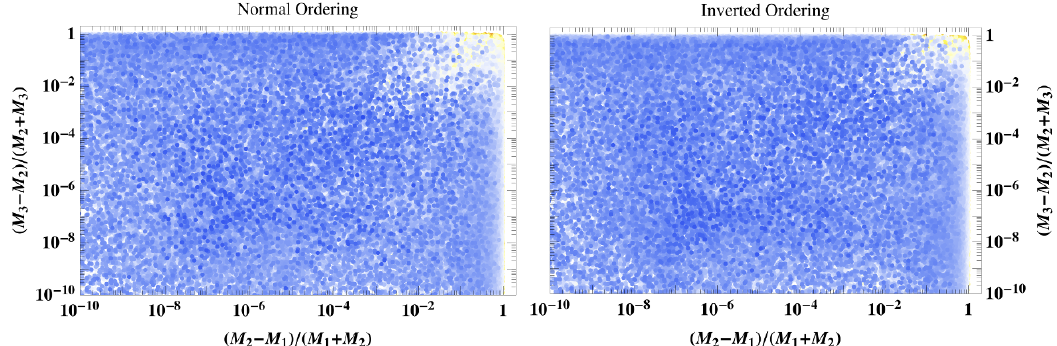
Figure 2 . Relative mass splittings for the viable BAU solutions in the model, for a normal (left panel) and inverted (right panel) ordering in the light neutrino mass spectrum. Colour coding as in (cid:12)gure